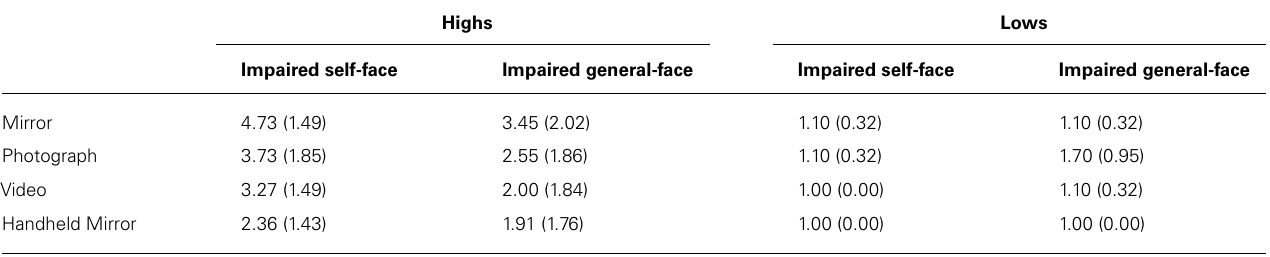
Table 2 |The postexperimental ratings of all participants regarding the extent to which they believed they were looking at a stranger in each of the visual